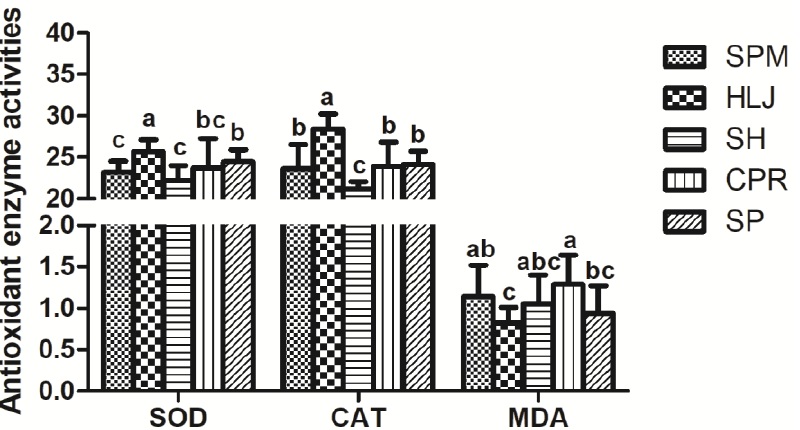
Figure 2. Antioxidant capacity in five species of common carp. Antioxidant enzymes were assayed,